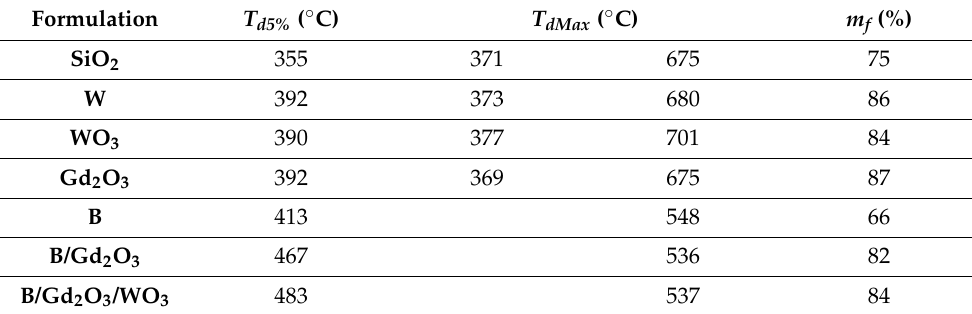
Figure 9. TGA curves for the 3D-printed cylinders: ( a ) weight percent for samples without boron; ( b ) derivative weight percent for samples without boron; ( c ) weight percent for samples with boron; and ( d ) derivative weight percent for samples with boron. Table 4. Thermal stability properties of the 3D-printed formulations.